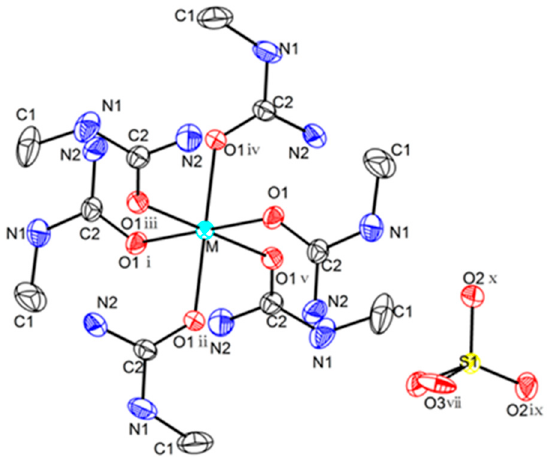
Figure 1. The coordination environment of the M (Ni 2+ /Mn 2+ ) in (I), (II), (III), and (IV), shown with 30% probability displacement ellipsoids. H atoms have been omitted for clarity.